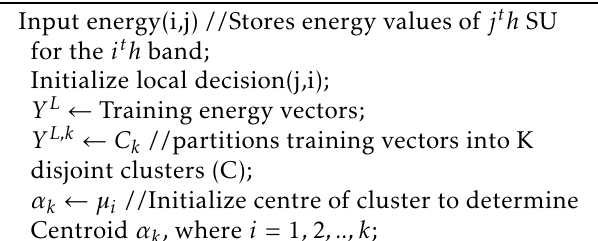
Algorithm 2: Proposed CSS scheme using k-means clustering algorithm